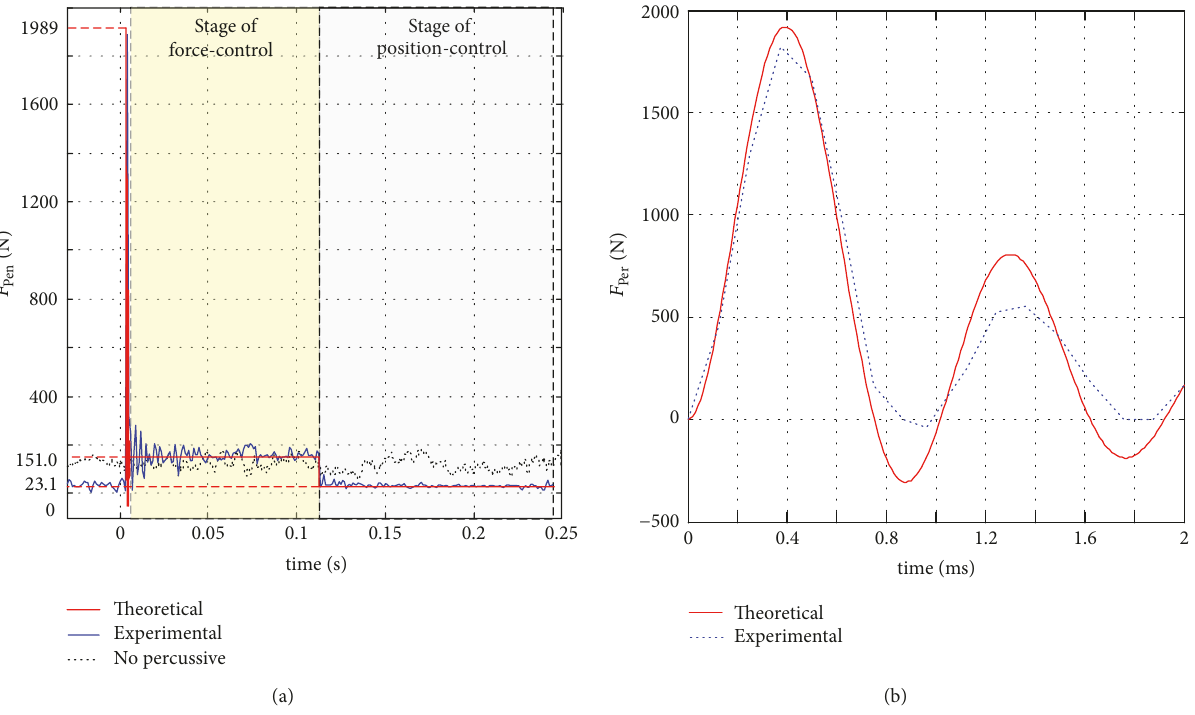
Figure 10: Variation trend of the resistant force on the lunar rock simulant in a single impact